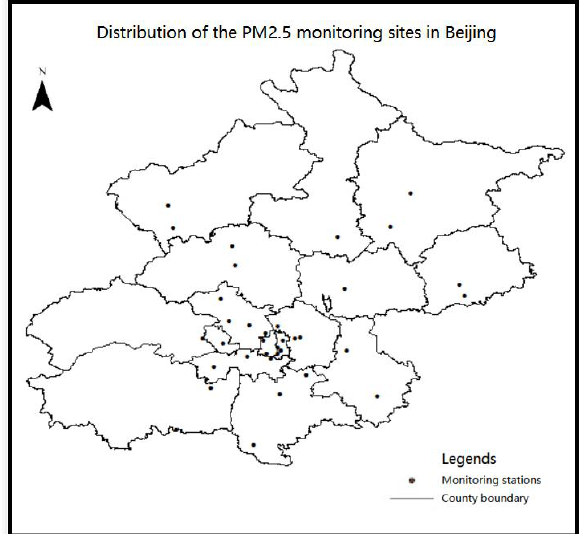
Figure 1. Location of 34 monitoring sites in